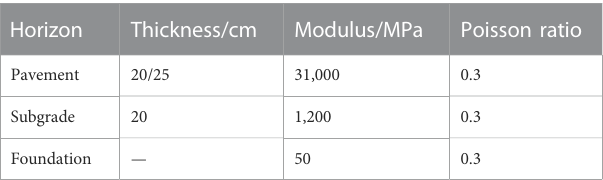
TABLE 1 Calculation parameters of the MFBM model.